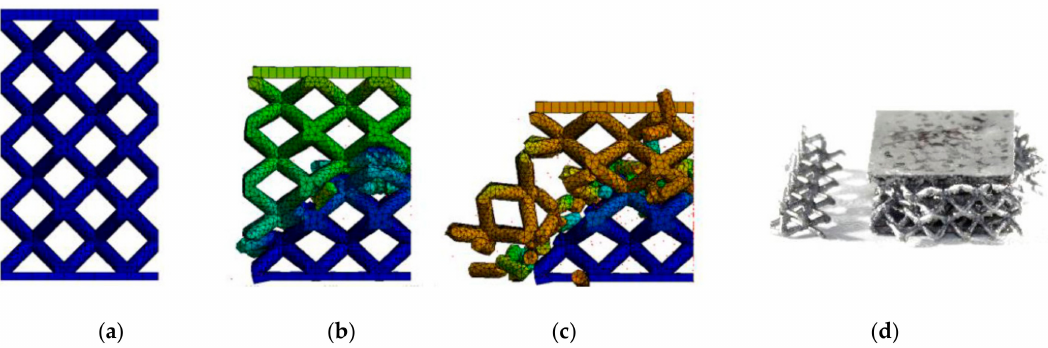
Figure 12. ( a ) Comparison of the results of the IT-0.8 series and the numerical simulation with ( a ) circular cross-section; and ( b ) elliptical cross-section.